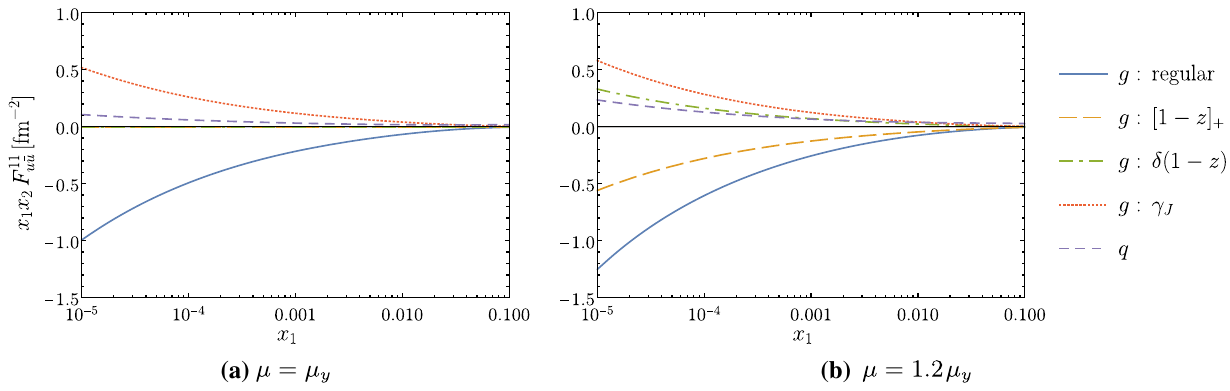
Fig. 10 Individual contributions to F 11 at x 1 = x 2 at two-loop level, evaluated with x 1 x 2 ζ p = μ 2 for two values of μ . The curves labelled “ g ” u ¯ u are for the splitting g → q ¯ q , and the curve labelled “ q ” is for the sum of all splitting contributions initiated by a quark or an antiquark. The labels “regular”, “ [ 1 − z ] + ”, and “ δ( 1 − x ) ” refer to the different parts of the kernels V 11 [ 2 , 0 ] + L y V 11 [ 2 , 1 ] discussed below Eq.